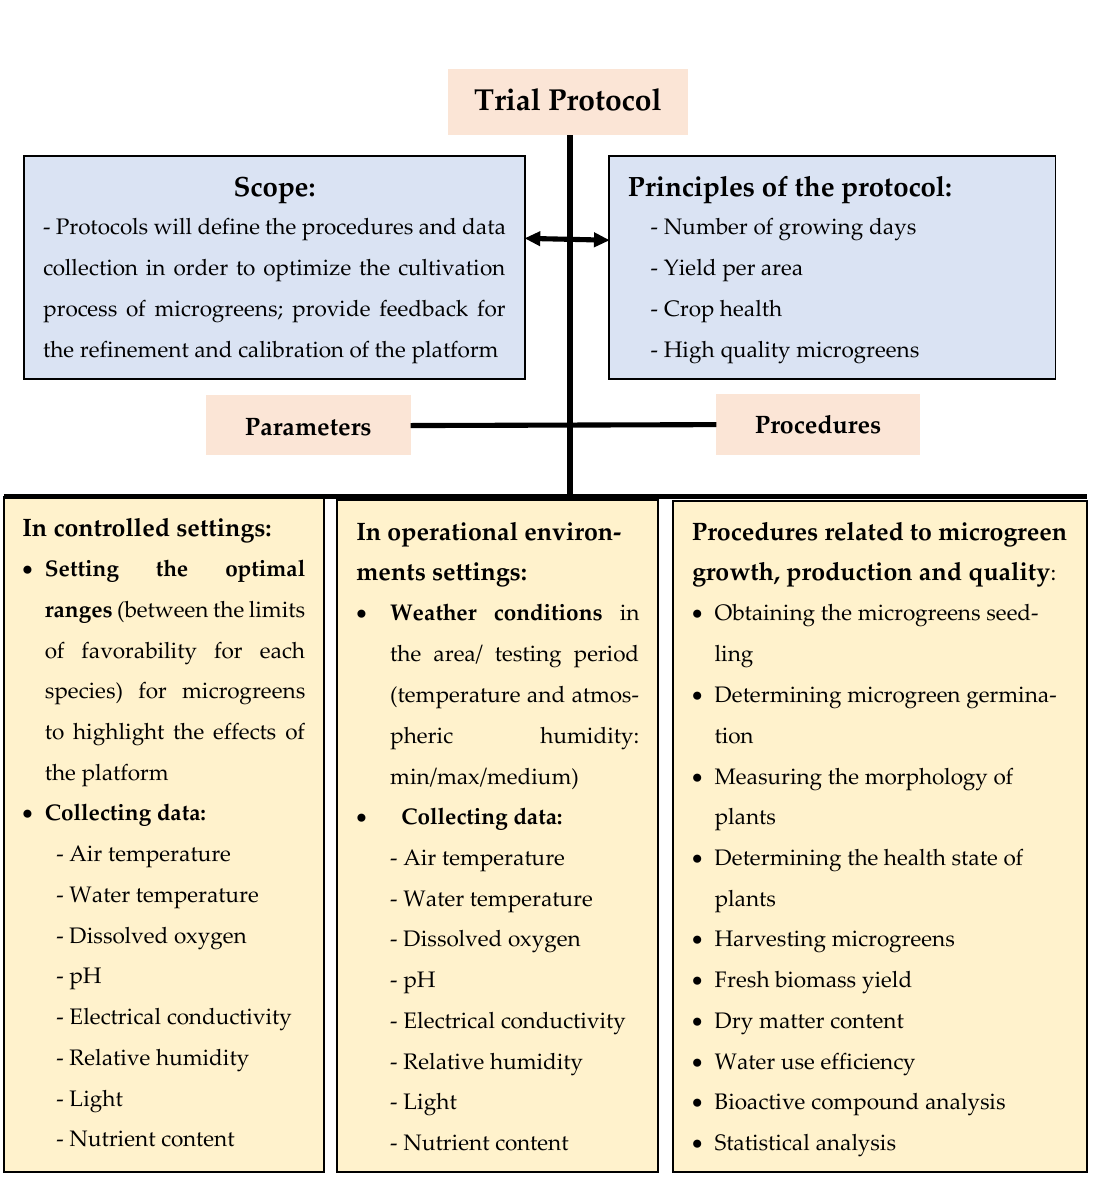
Figure 1. Scheme of procedures and parameters proposed for the trial protocol.